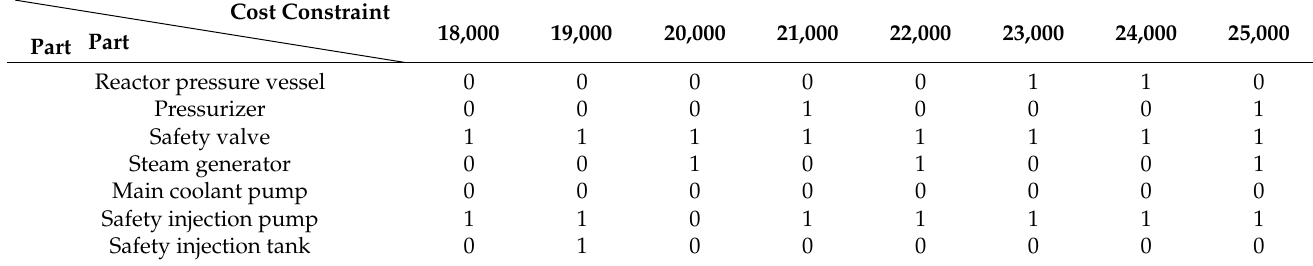
Table 6. X10 and X9 failures, t = 1000